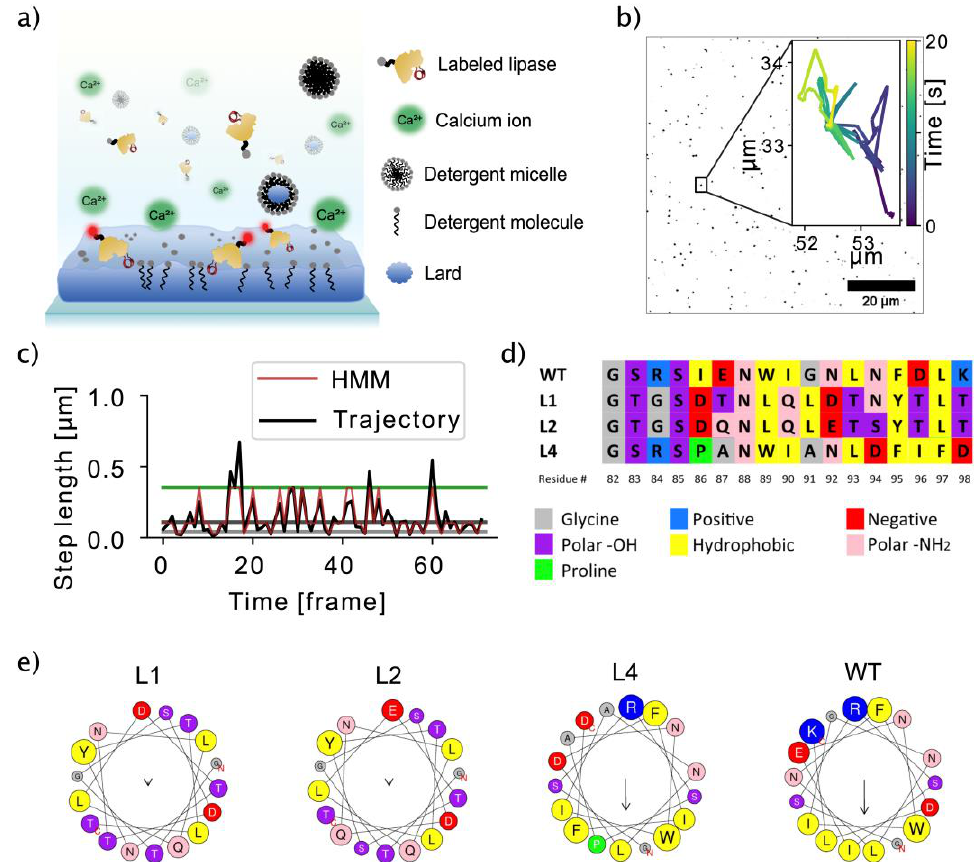
Figure 1. SPT assay of lipase activities in application conditions. ( a ) Schematic illustration of the experimental setup. Diffusion of SeTau 647-labeled TLL enzymes on a lard surface was investigated by TIRF microscopy in the presence of calcium ions and surfactants. ( b ) A representative micrograph displaying individual TLL molecules (black dots) bound to the lard surface. The zoom is a temporal trajectory of a single TLL variant’s diffusion, which is color-coded according to observation time. ( c ) Typical step length traces showing the reversible transition between different states, along with the corresponding idealistic traces discovered via HMM analysis. ( d ) Amino acid sequence alignment of lid region for WT and the three variants used in this work. The charge, polarity, and type of amino acid are indicated by color coding. ( e ) The lid structures are displayed as a helical wheel generated by HELIQUEST [37].